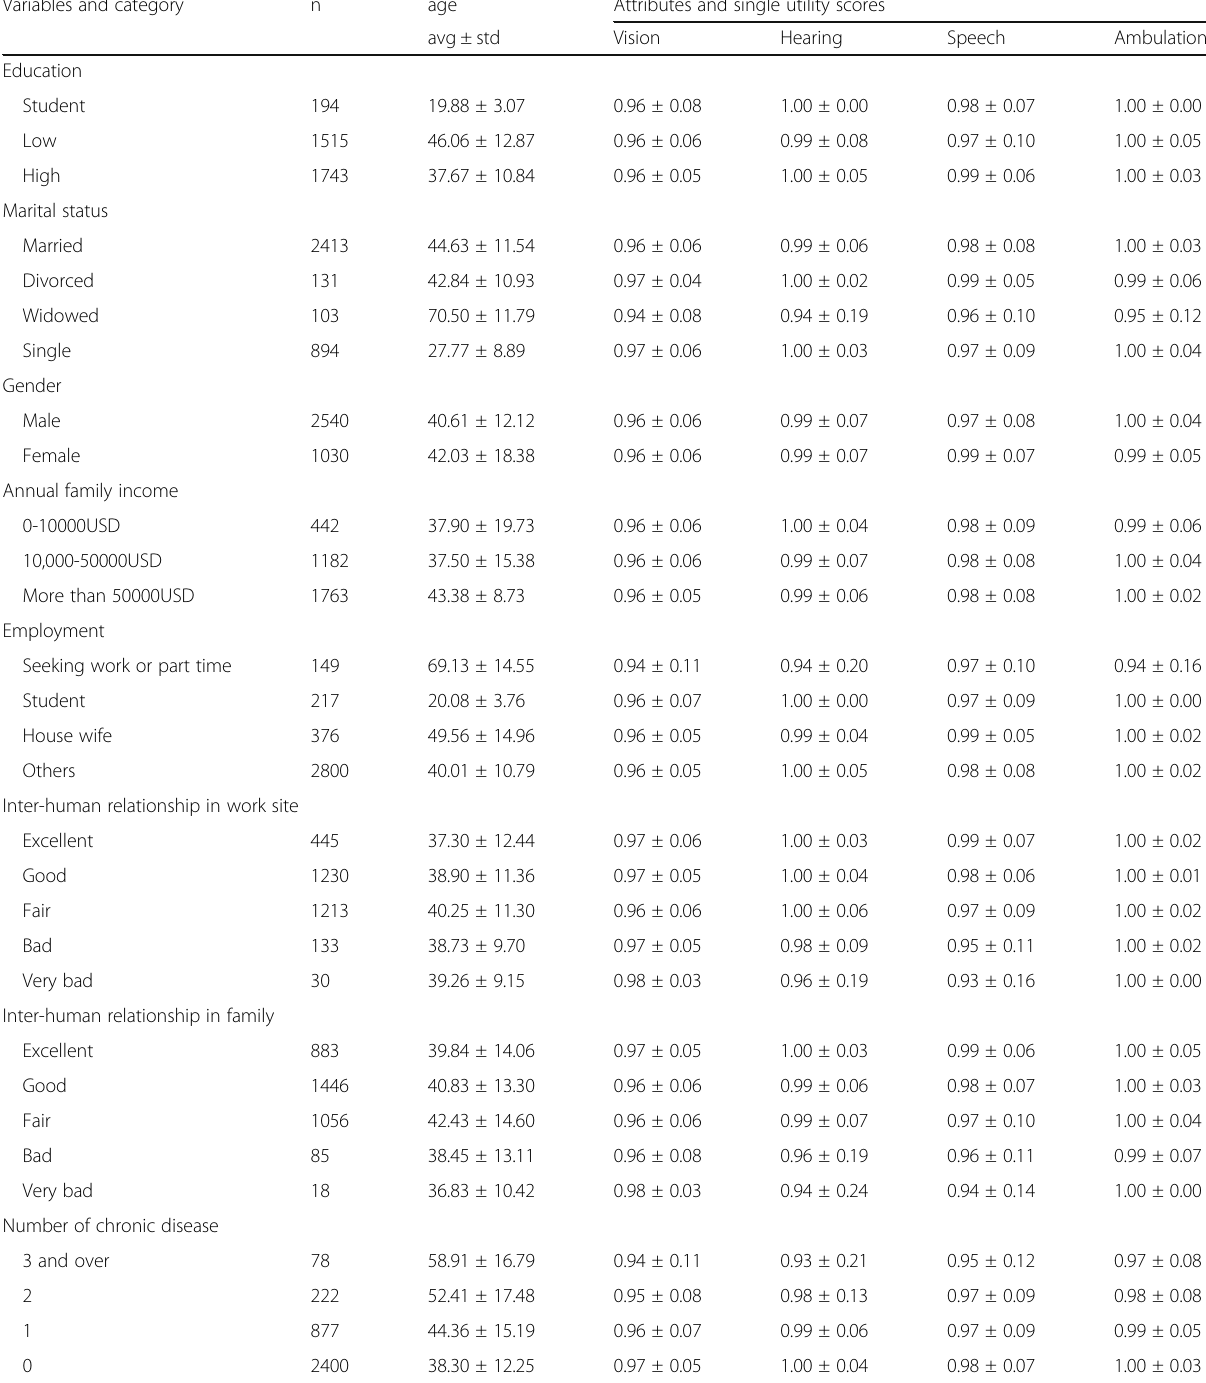
Table 4 Mean utility scores (single attribute, multiattribute global HUI3) and VAS score by personal characteristic variables Variables and